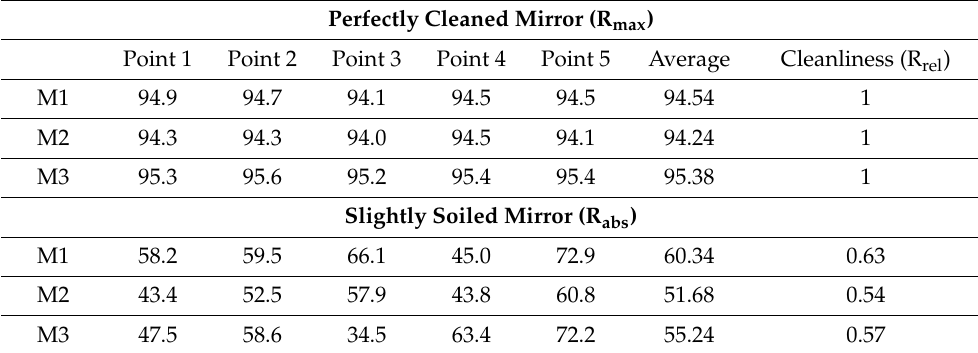
Figure 5. From left to right: dirty mirror and cleaning results after different experiments. Table 1. Reflectance of perfectly cleaned and slightly soiled